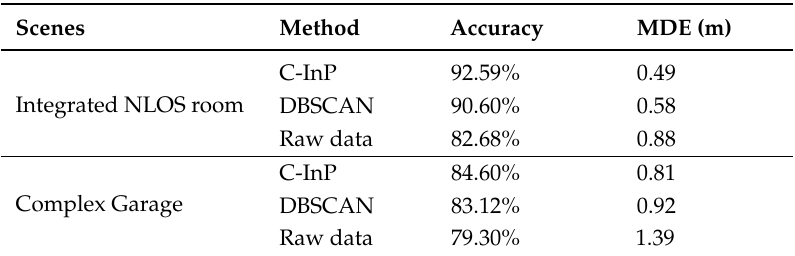
Table 2. Comparison of different preprocessing